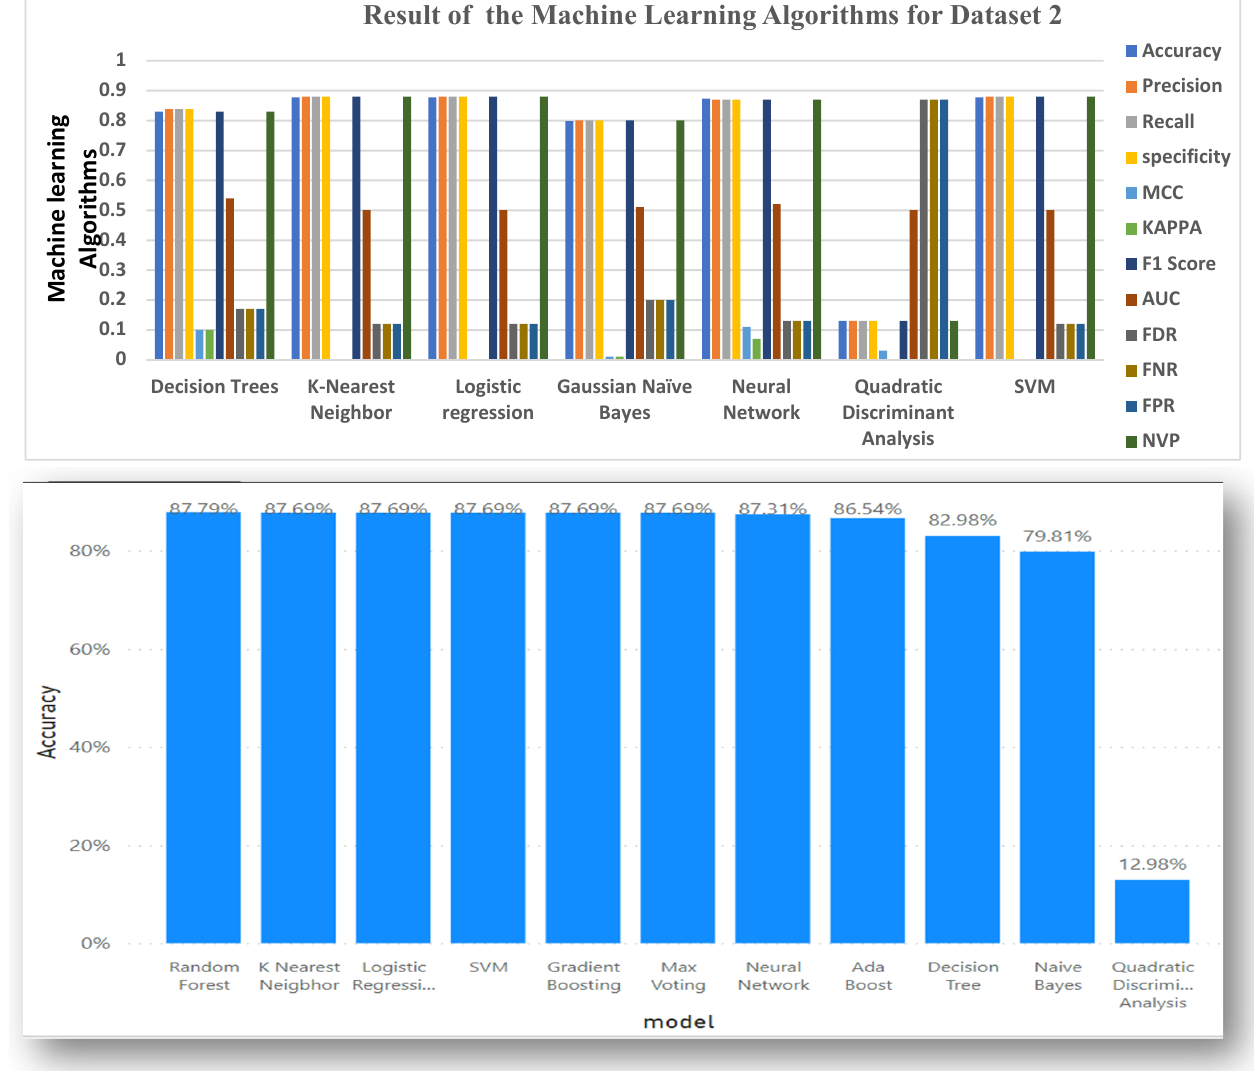
Figure 3. Graphical representations of Evaluation Metrics against Machine Learning Algorithms and ensemble learning for Dataset 2.